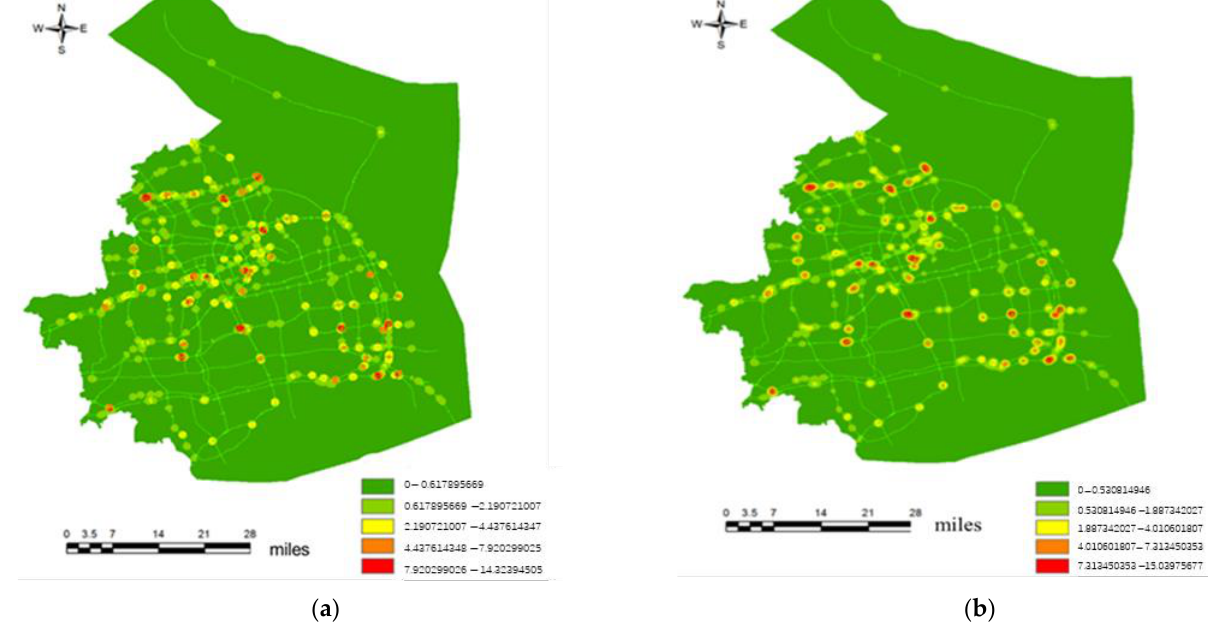
Figure 6. Accident black spot identification results of the selected comparison method. ( a ) Recognition result of accident frequency method. ( b ) Recognition result of kernel density estimation.